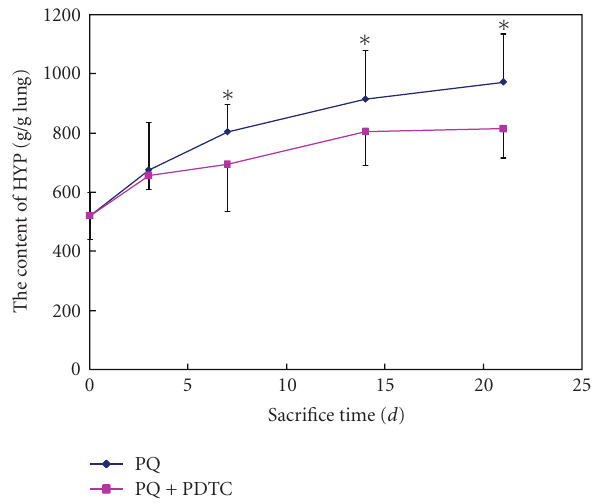
Figure 1: The content of HYP in lung tissue from groups of the control, PQ treatment, and PQ+PDTC treatment. ∗ compared with the control, P < .